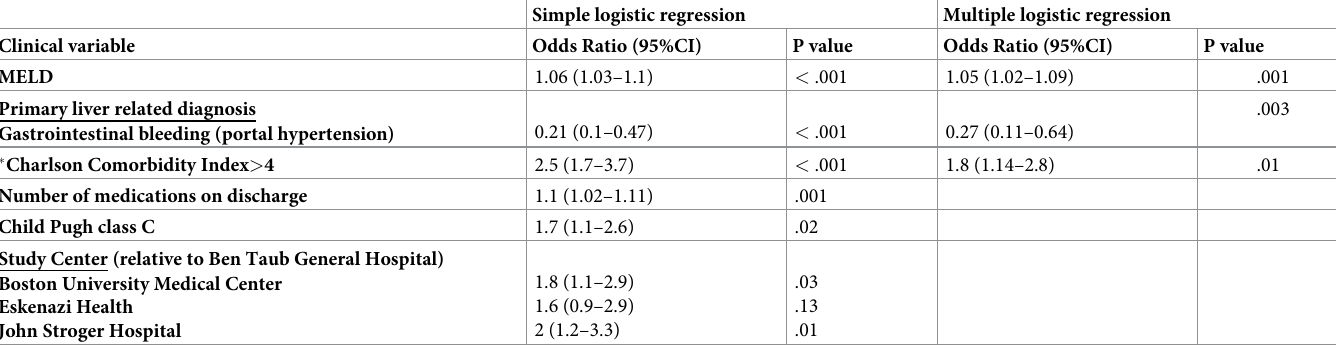
The study cohort was racially and ethnically diverse with differing hospital mortality rates. We compared non-Hispanic White, Black, and Hispanic patients (Table 6). Black patients were slightly older and had a higher median CCI compared to White and Hispanic patients. The Table 5. The predictors of all-cause 30-day readmission on simple and multiple logistic regression. Simple logistic